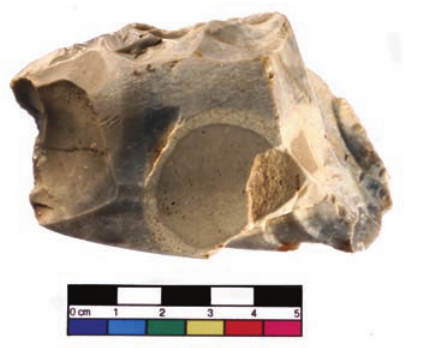
Figure 3 Damaged flint axe from Trench